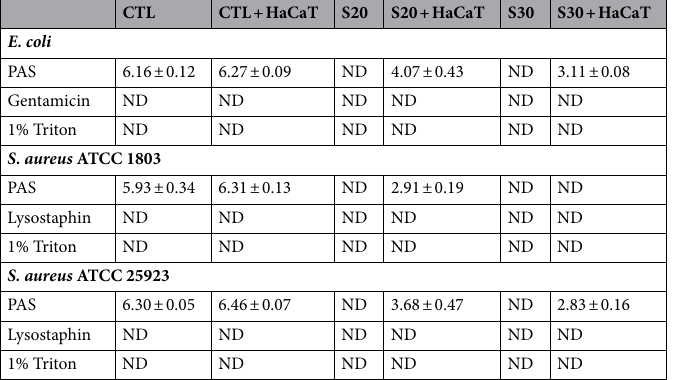
Table 1. Antibiotic invasion assay against E. coli , S. aureus ATCC 1803 and S. aureus ATCC 25923. Results are the surviving bacterial concentration in log CFU/mL shown as mean ± S.D. of three determinations. ND = not detected, limit of detection 2 log.